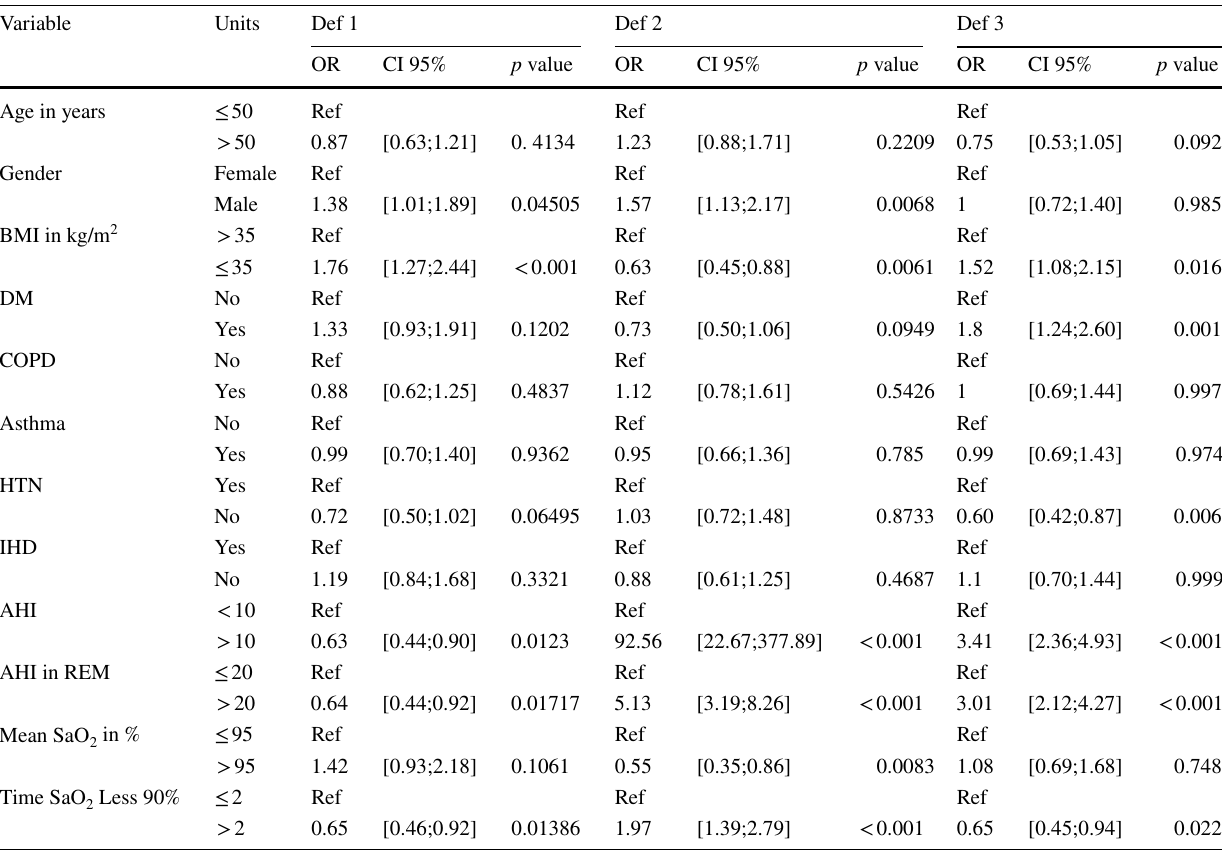
Table 3 Univariate analysis of significant variables using logistic